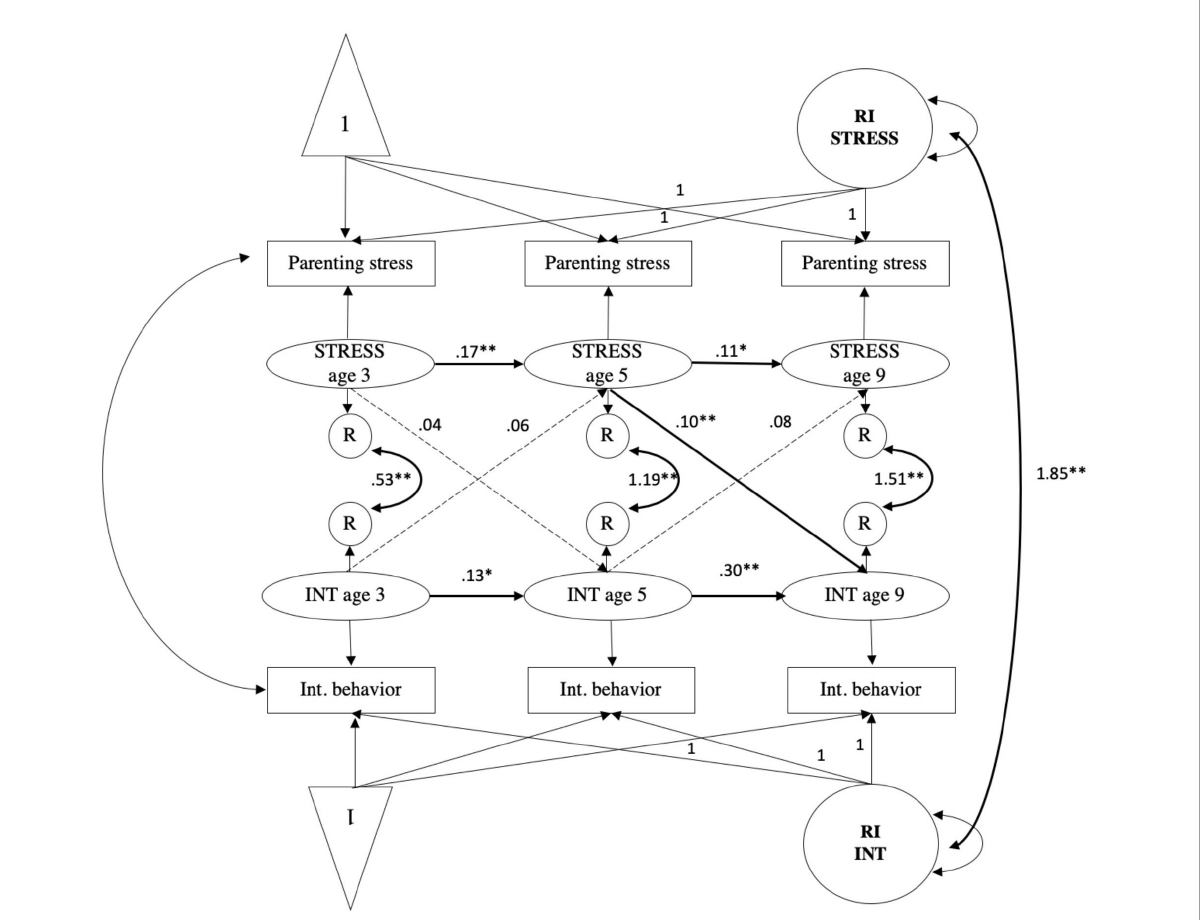
FIGURE1 Random intercept cross-lagged panel model showing relations among parenting stress (STRESS) and child internalizing behaviors (INT) across three waves. Age 3, wave 2; age 5, wave 3; age 9, wave 5; R, residual variance; RI INT, random intercept child internalizing behavior; RI STRESS, random intercept parenting stress. Standardized estimates reported. Gray dashed paths indicated non-significant estimates. ∗ p < 0.01, ∗∗ p < 0.001.